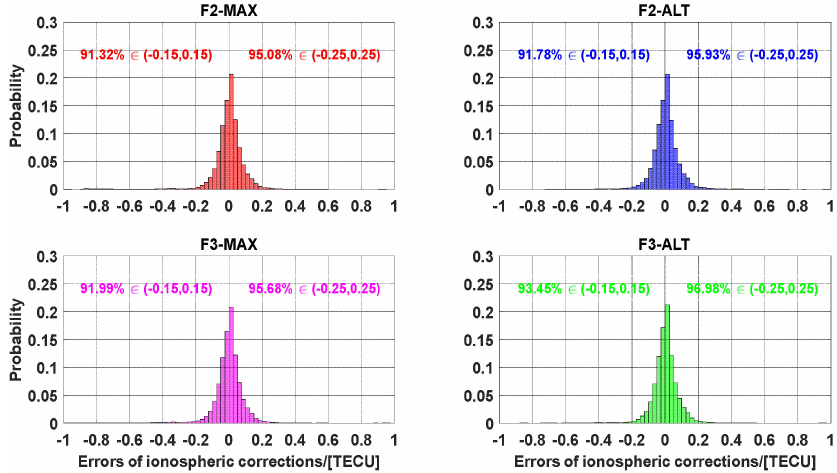
Figure 15. Error distribution of the SD slant ionospheric